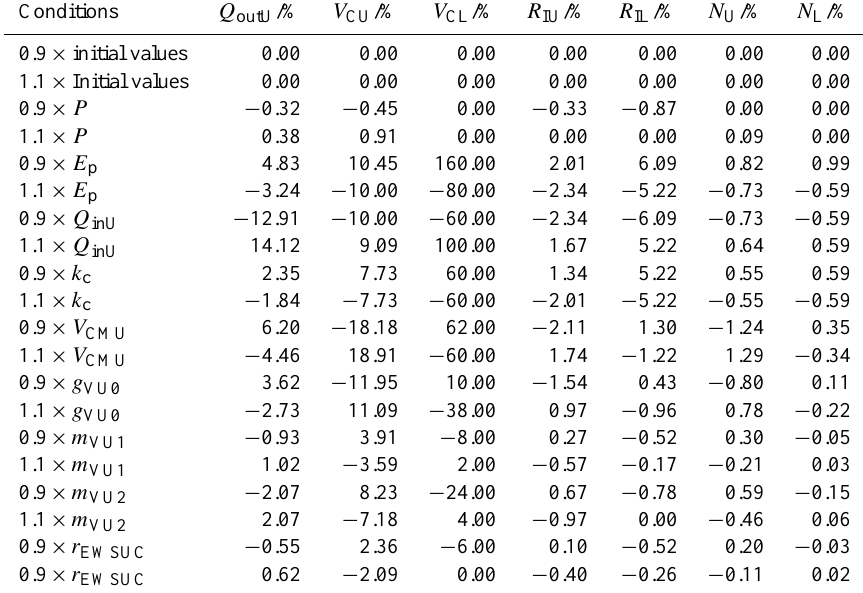
Table 5. Changing rate of mean values of state variables during the last 60 years of system evolution for sensitivity